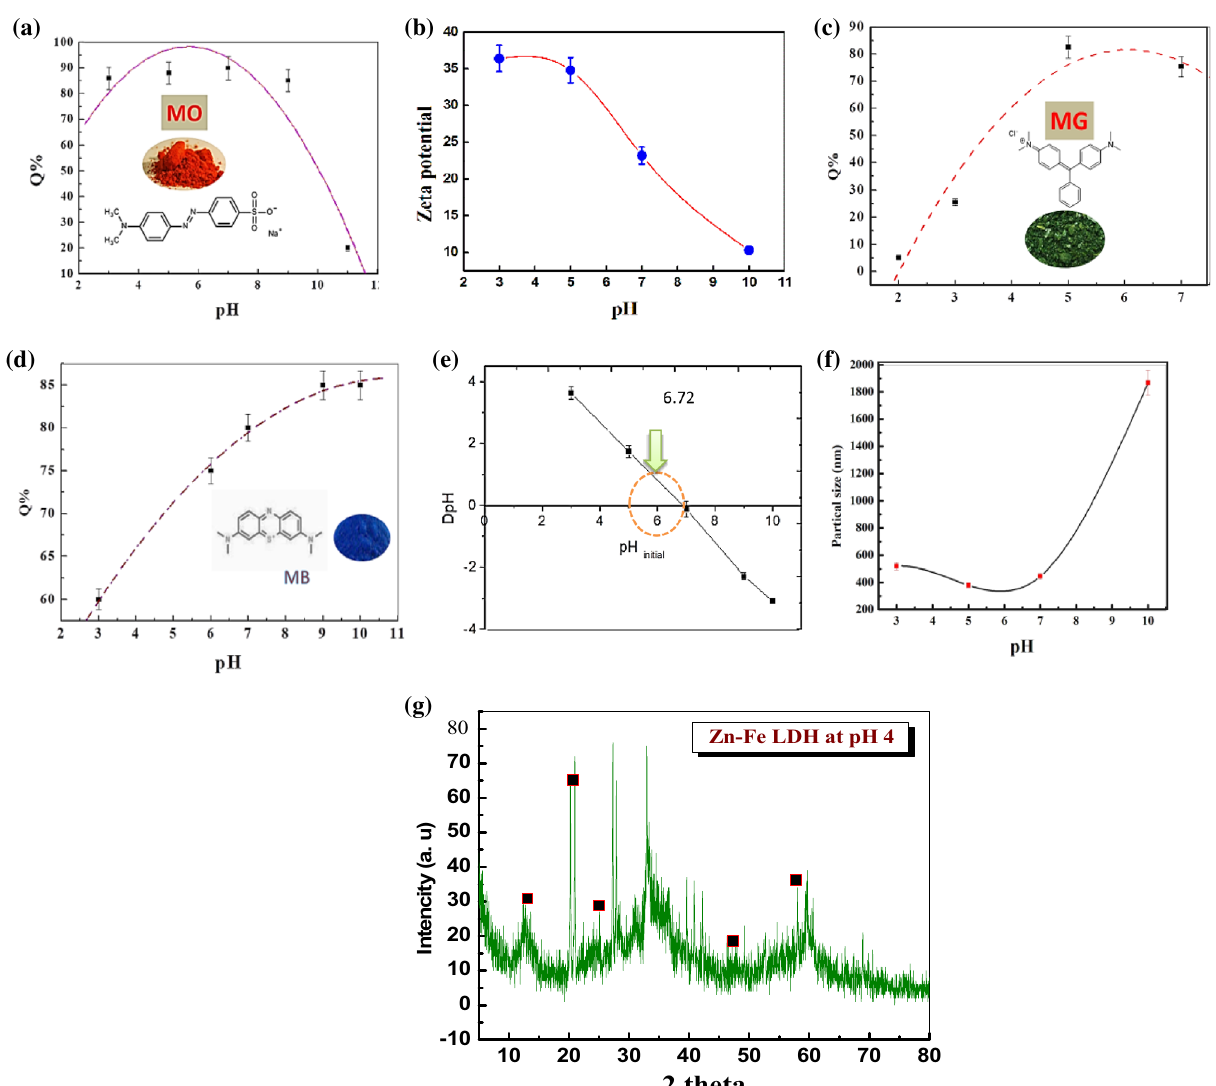
Figure 11. Percent removal of different dyes ( a , c , d ); ( b ) zeta potential; ( e ) PZC; ( f ) partial size distribution of Zn–Fe LDH at different pH values; and ( g ) XRD spectra of Zn–Fe LDH at pH